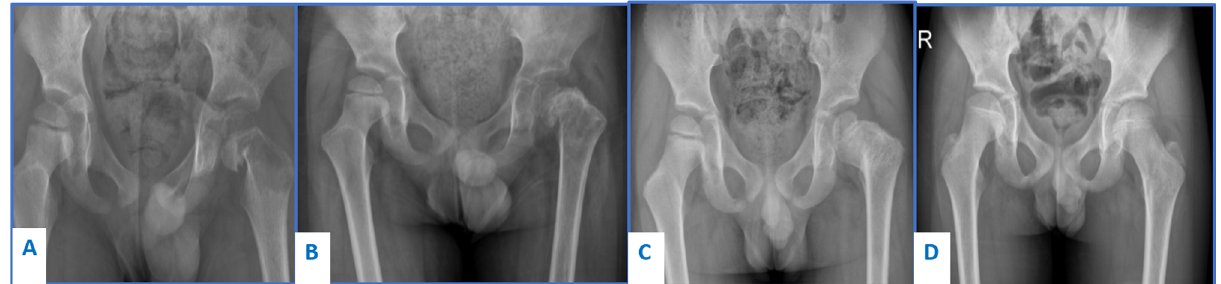
Figure 3. Plain radiograph of the left hip of a 5-year-old boy diagnosed with LCH in the femoral neck managed conservatively. (A) Pathologic fracture of the left femoral neck on top of lytic lesion. (B) Healing of the fracture after 3 months. (C) Remodeling of the femoral neck at 1 year of follow-up. (D) Complete remodeling after 7-year follow-up.